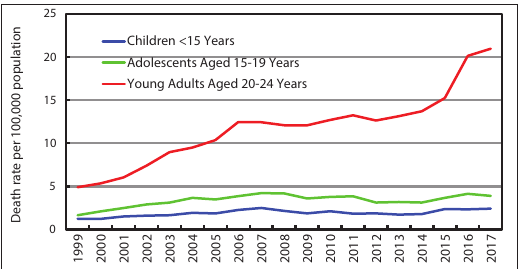
Figure 5: Trends in Drug Overdose Mortality among Children, Adolescents, and Young Adults, United States, 1999-2017 Death rates for children aged <15 years are per million, while death rates for adolescents and young adults are per 100,000 population. Source: Data derived the National Vital Statistics System, Nation - al Mortality Database.